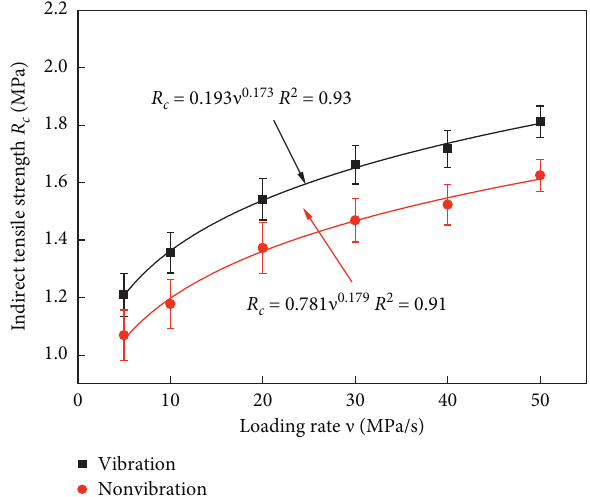
Figure 5: Indirect tensile strength of cement-treated aggregates affected by loading rates.